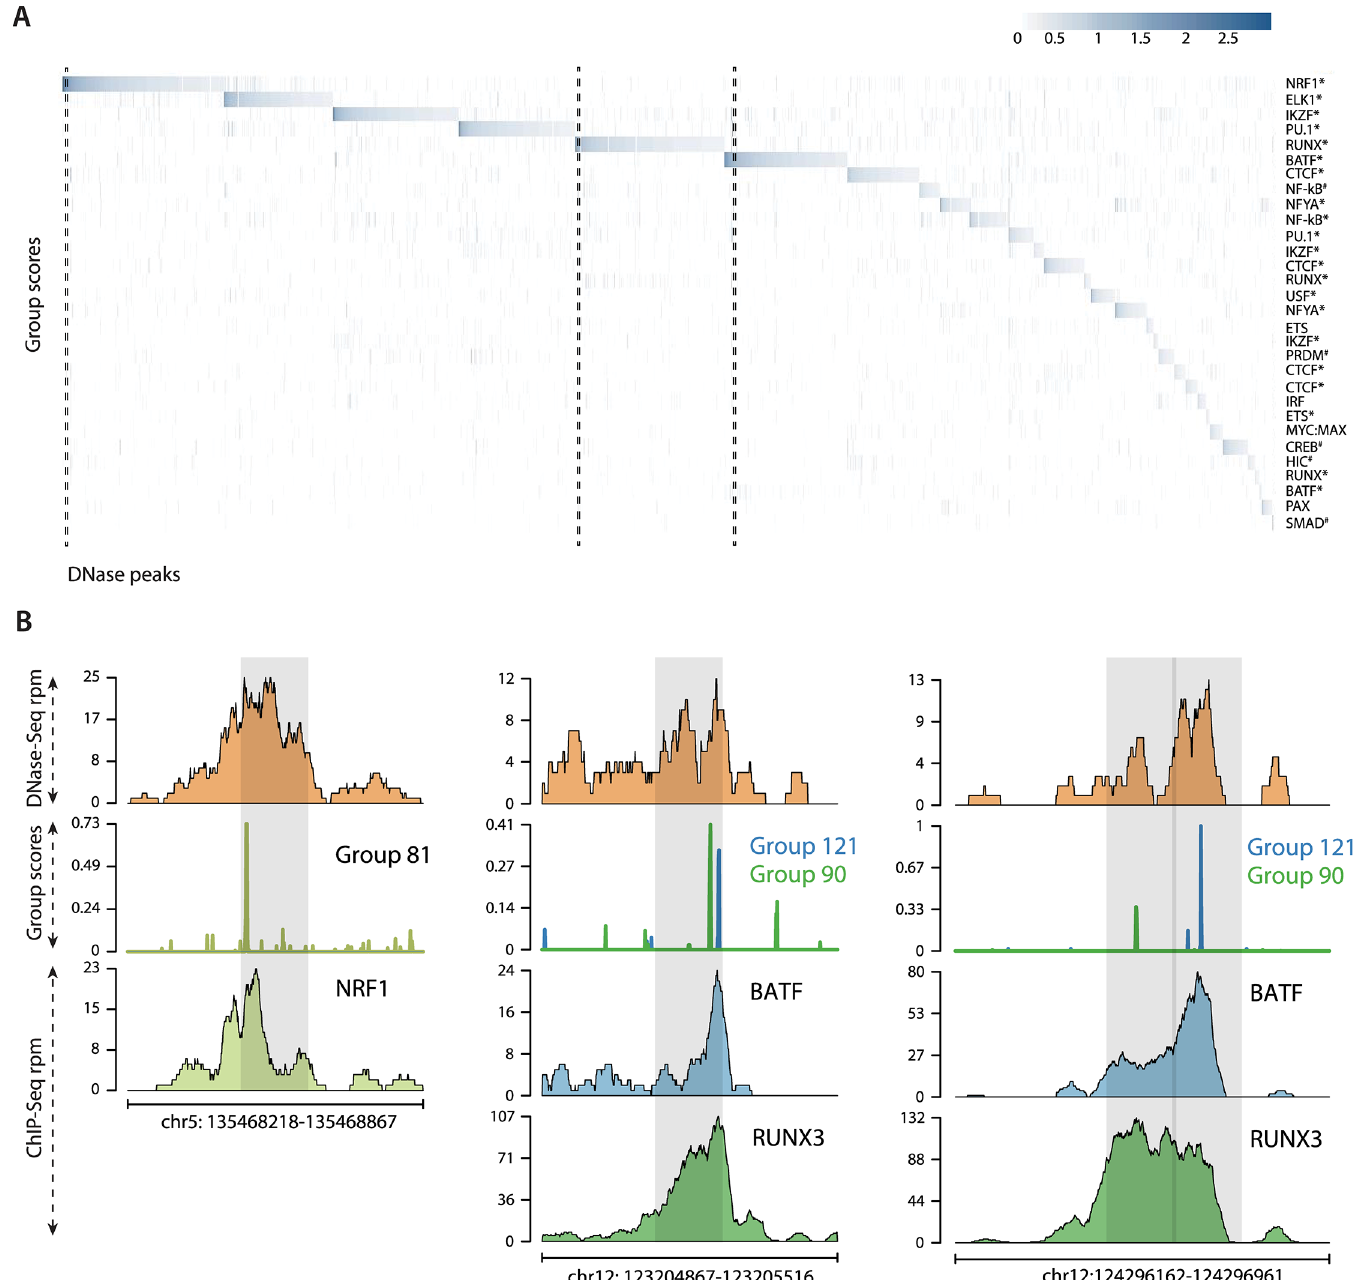
Fig 5. Sequence preferences of GM12878 DNase-seq peaks. (A) Heatmap showing the group scores for top groups over 16,891 GM12878 DNase-seq peaks. Note that some peaks have a sequence signal for a single factor while others have signals for multiple factors (FDR-corrected p < 0.01). All the group predictions identified by “ * ” have been validated by ChIP-seq data, while “ # ” indicates no ChIP-seq data available in ENCODE. The dashed boxes highlight the specific examples illustrated in Fig 5B. (B) The left panel shows a DNase peak with a strong score for a single transcription factor (NRF1). The middle panel shows DNase peaks with moderate scores for both BATF and RUNX. The left panel shows different binding preferences in adjacent split peaks derived from a single broad peak. All the predictions are validated by ChIP-seq.